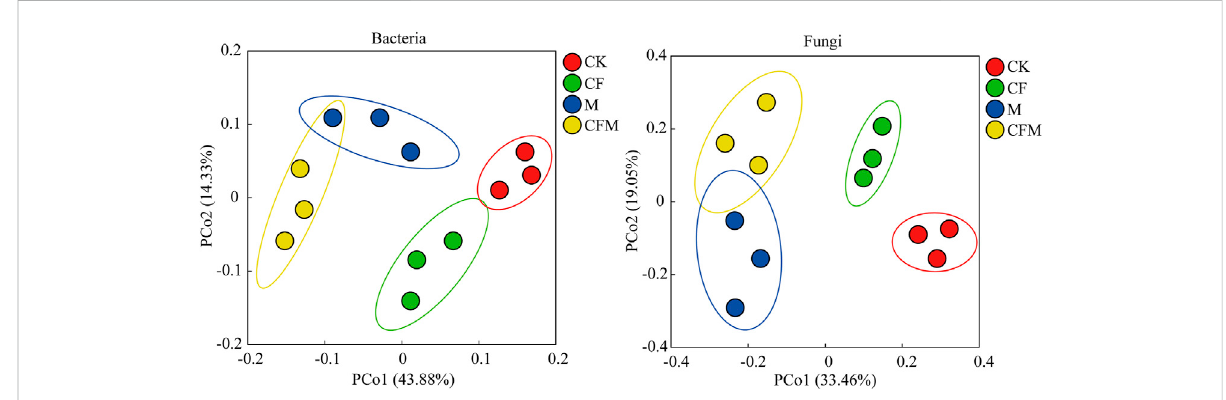
FIGURE 1 Principal coordinates analysis (PCoA) representing variation of soil bacterial and fungal communities across the different treatments after 16 years (2004 – 2019). Only OTUs with relative abundances > 0.01% were included in the